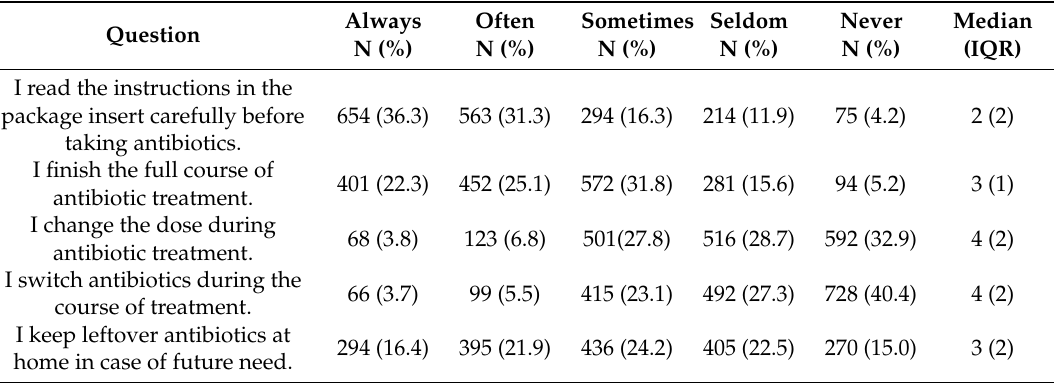
Table 4. Practices of participants about antibiotics ( n = 1800).